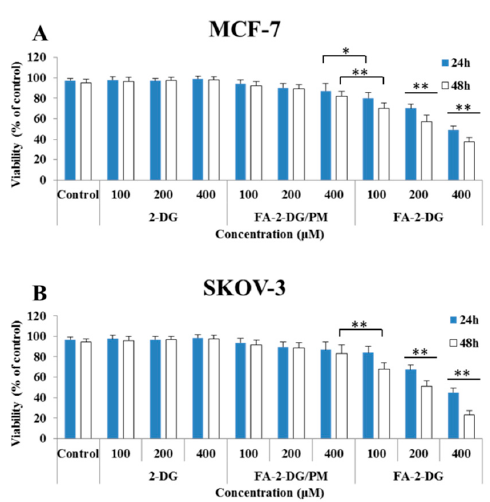
Figure 3. Cell viability assays of different treatments. ( A ) MCF-7 cells were treated with different groups of compounds for 24 h and 48 h. ( B ) SKOV-3 cells were treated with different groups of compounds for 24 h and 48 h. Cell viability was determined by MTT assays. The results are expressed as a mean percentage of controls ± standard deviation (SD) in three separate experiments. Significance was calculated by ANOVA and Duncan’s test (* p < 0.05, ** p < 0.01).